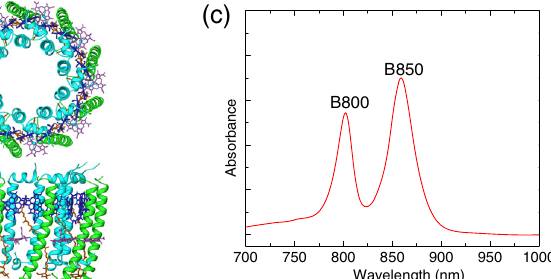
ringisshowninblue,thelooselypackedB800ringinmauve,thecarotenoidchains in brown, the α -apoprotein chains in cyan and the β -apoprotein chains in green; c steady state absorption of LH2 bare fi lm on glass substrate, where the B800 and B850 absorption peaks are well